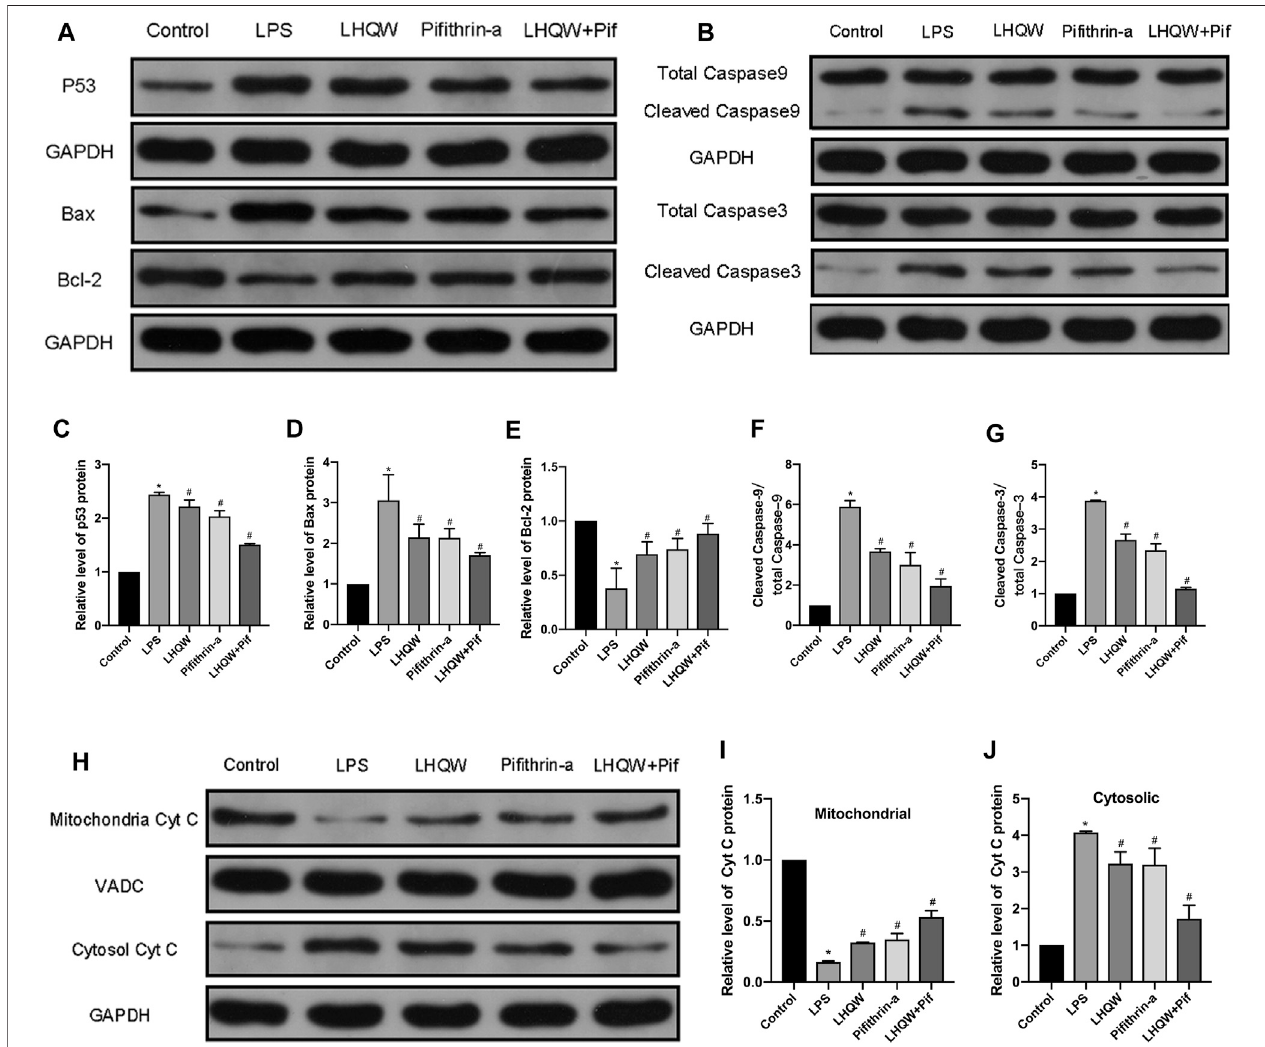
FIGURE 6| Effect ofLHQW on p53-mediated intrinsic apoptosis. (A) Representative Western blot images ofp53, Bax and Bcl-2. (B) Representative Western blot images of caspase-3 and caspase-9. (C – G) Comparison of the gray values of all proteins in mice by ImageJ software (with GAPDH loading control). (H) Representative Western blot images of cytochrome C in mitochondria and cytosol. (I,J) Comparison of the gray values of cytochrome C in mitochondria and cytosol in mice by ImageJ software (with GAPDH and VADC loading controls). LPS, 5 mg/kg; LHQW, 1,400 mg/kg/day; p53 inhibitor, pi fi thrin- α (3 mg/kg/day). Data are shown as mean ± SD from one-way ANOVA followed by Tukey ’ s post-hoc test. * p < 0.05, versus Control; # p < 0.05, versus LPS.